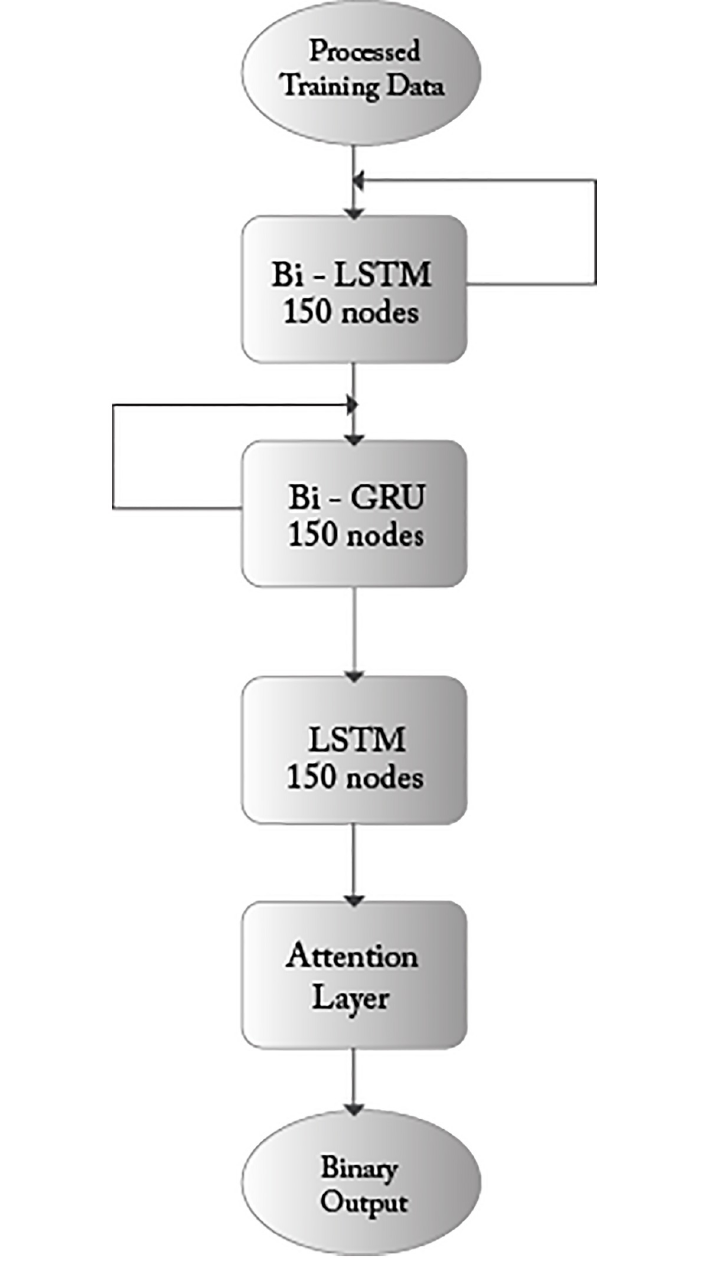
Fig 4. The high-level topology of DP-AGL learning